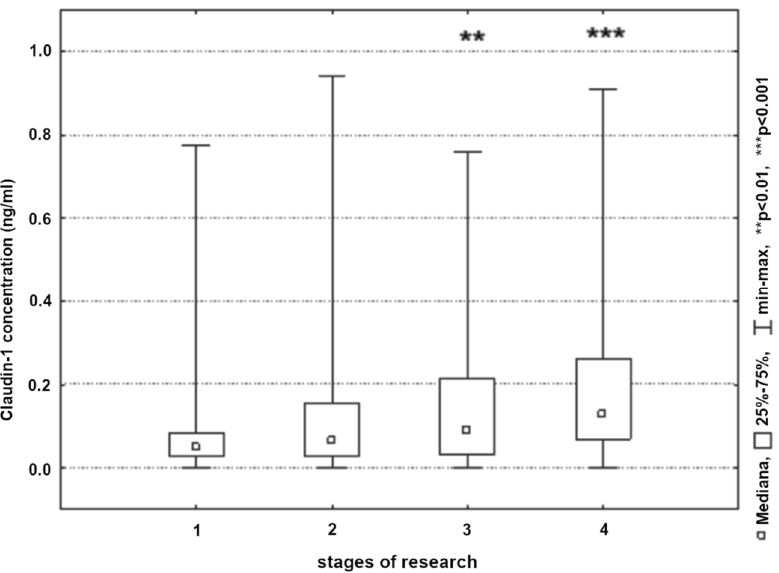
Figure 5. Claudin-1 concentration in patients in the next stages of research (1, 24 h before surgery; 2, 8 h post-surgery; 3, 24 h post-surgery; and 4, 48 h post-surgery).